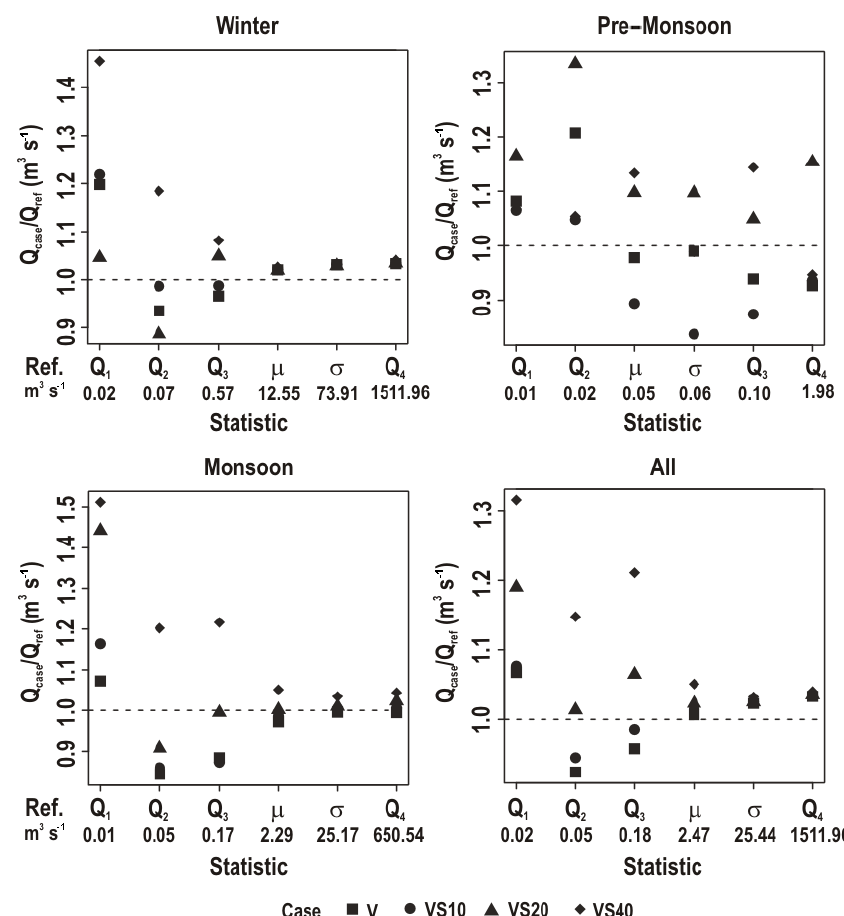
Figure 9. Long-term ratios ( Q case /Q ref ) between streamflow probability distribution properties for the forest thinning scenarios and the reference case, computed from hourly simulated time series for typical winter (January), pre-monsoon (June) and monsoon (August) months and all months. Statistical properties include first, second, third and fourth quartiles ( Q 1 , Q 2 , Q 3 and Q 4 ), mean ( µ ) and standard deviation ( σ ). In all plots, the dashed line represents the reference